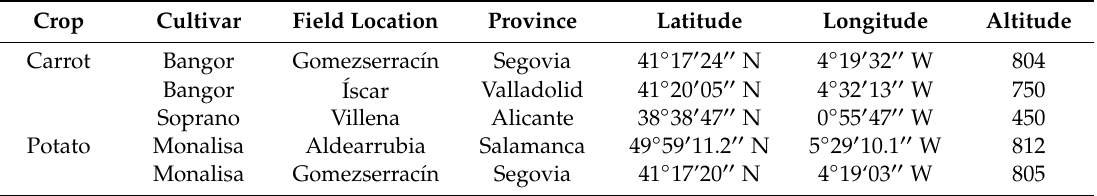
Table 1. Location and information of carrot and potato fields surveyed by di ff erent sampling methods during the cultivation cycles of 2015, 2016 and 2017 in